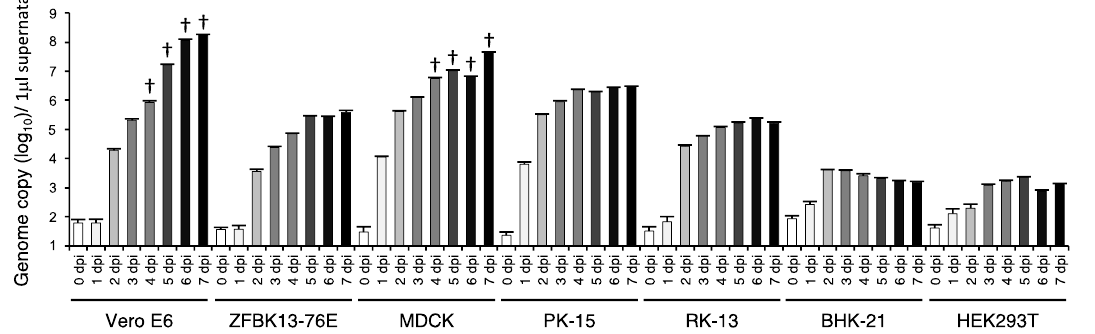
Figure 5. Quantitation of viral DNA in the supernatants of various mammalian cells infected with EhAdV 06-106 using real-time PCR. Data are shown as the means and standard deviations from triplicate reactions. Daggers indicate the points when cytopathic effect was remarkable. Dpi indicates day(s) post infection. ZFBK: Fruit bat kidney; MDCK: Madin-Darby canine kidney; PK: Porcine kidney; RK: Rabbit kidney; BHK; Baby hamster kidney; HEK: Human embryonic kidney.